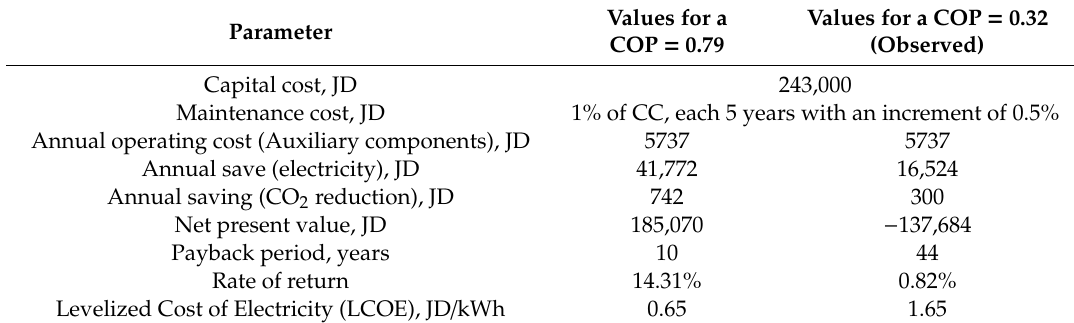
Table 3. Summary of the economic analysis of the solar absorption for the claimed and the observed results.